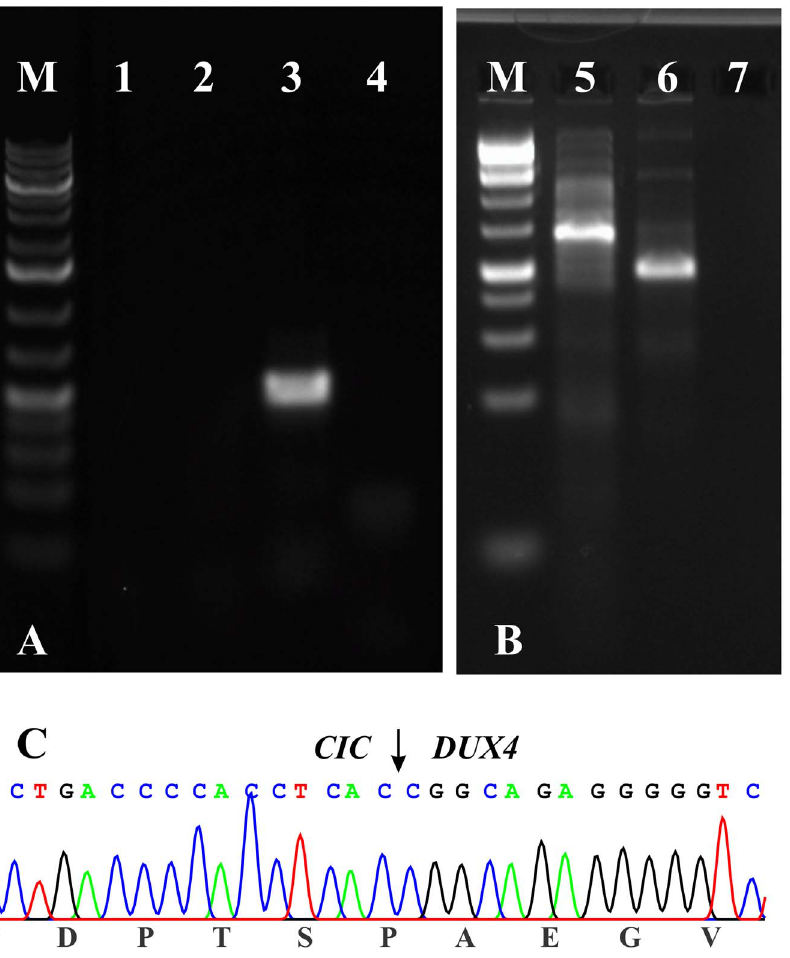
Figure 3. RT-PCR results for the expression of CIC-DUX4 in the tumor. A) The initial PCR with Premix Taq and the primer set CIC-4105F/ DUX4-1538R (lane 1) as well as the nested PCR with the primers CIC-4283F/DUX4-1507R (lane 2) did not amplify any cDNA fragments. The primer set CIC-4238F/CIC-4958R (lane 3) amplified a CIC cDNA fragment suggesting the good quality of the synthesized cDNA. Lane 4, Blank, no RNA in cDNA synthesis. B) PCR amplifications using the PrimeSTAR GXL DNA polymerase and the primer combinations CIC-4377F/DUX4-1151R (lane 5) and